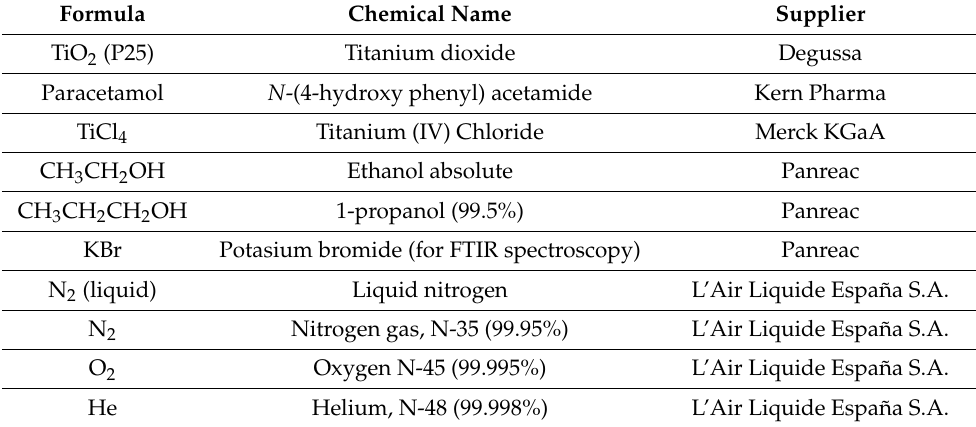
Table 3. Reagents and gases used and their supplier